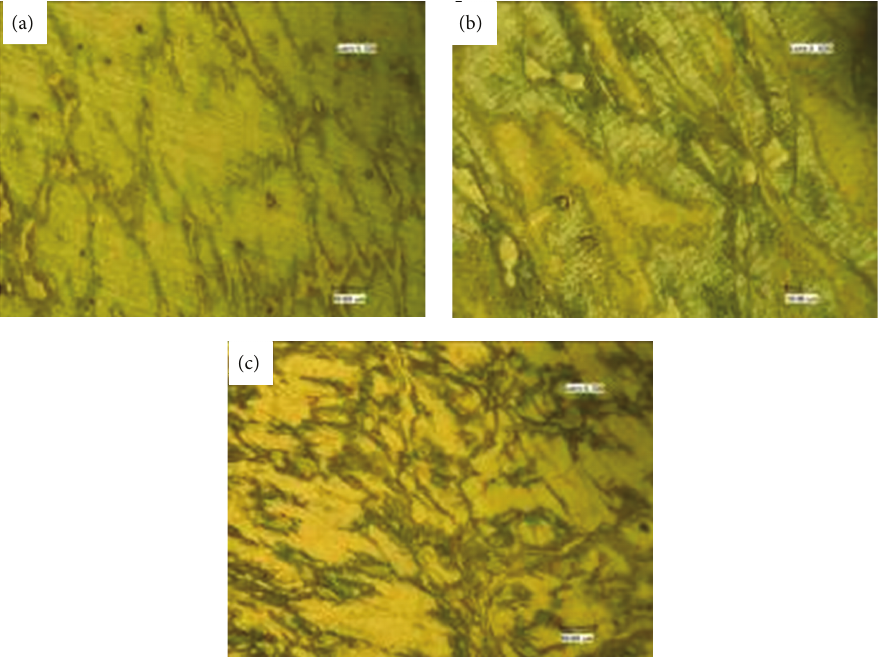
Figure 3: Microstructure evolution with deformation of 60% and 0.1 s −1 : (a) 𝑇 = 200 ∘ C; (b) 𝑇 = 300 ∘ C; (c) 𝑇 = 400 ∘ C.